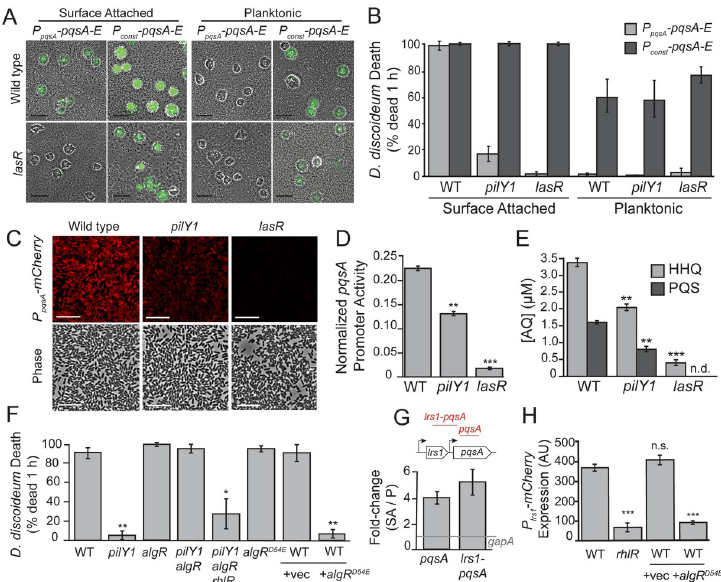
Fig 4. PilY1 and LasR promote surface-induced virulence through pqsABCDE expression. (A) Representative images of D . discoideum infected with surface-attached and planktonic P . aeruginosa expressing pqsABCDE genes under control of the endogenous pqsA promoter ( P ) or a strong constitutive promoter pqsA − pqsABCDE ( P const − pqsABCDE ) after 1 h of co-culture (scales bars = 50 μ m). Fluorescent calcein-AM staining indicates cell death. (B) Quantification D . discoideum killing by surface-attached and planktonic wild type, Δ pilY1 and Δ lasR P . aeruginosa after 1 h co-culture. (C) Representative images of surface-attached P . aeruginosa expressing a P pqsA − mCherry fluorescent reporter (scale bars = 10 μ m). (D) Mean fluorescence intensity per cell ( > 500 cells) of surface-attached P . aeruginosa expressing a ( P pqsA − mCherry ) promoter fusion normalized by the expression of a constitutive P tac -mCherry reporter. Values are mean ± SEM of three biological replicates (n = 3). (E) LC/MS-based quantification of HHQ and PQS in extracts of wild type, Δ pilY1 , and Δ lasR liquid cultures grown to OD = 1.5. Values are mean ± SEM of three biological replicates (n = 3), and concentrations were calculated using a standard curve constructed from purified AQ standards (n.d. = not detected). (F) Quantification D . discoideum killing by mutants in the AlgR-PilY1 pathway after 1 h co-culture. (G) qRT-PCR analysis comparing relative transcript abundance in surface-attached to planktonic P . aeruginosa after 1 h growth on a surface, with diagram showing relative amplicon positions (red lines) in the pqsA gene and upstream regions. Values are mean ΔΔ Ct values ± SEM (n = 3 biological replicates) relative to the gapA control transcripts. (H) Mean fluorescence intensity per cell ( > 500 cells) of surface-attached P . aeruginosa expressing a ( P ) promoter fusion. Values are mean ± SEM of three biological replicates (n = 3). Values in (B) and (F) lrs1 − mCherry are mean ± SEM of three biological replicates (n = 3). Statistical analysis was performed against wild type (Student’s t- test, two-tailed, � = p < 0.05, �� p < 0.01, ��� p < 0.001). Approximately 150–300 cells were analyzed for each measurement in (B) and